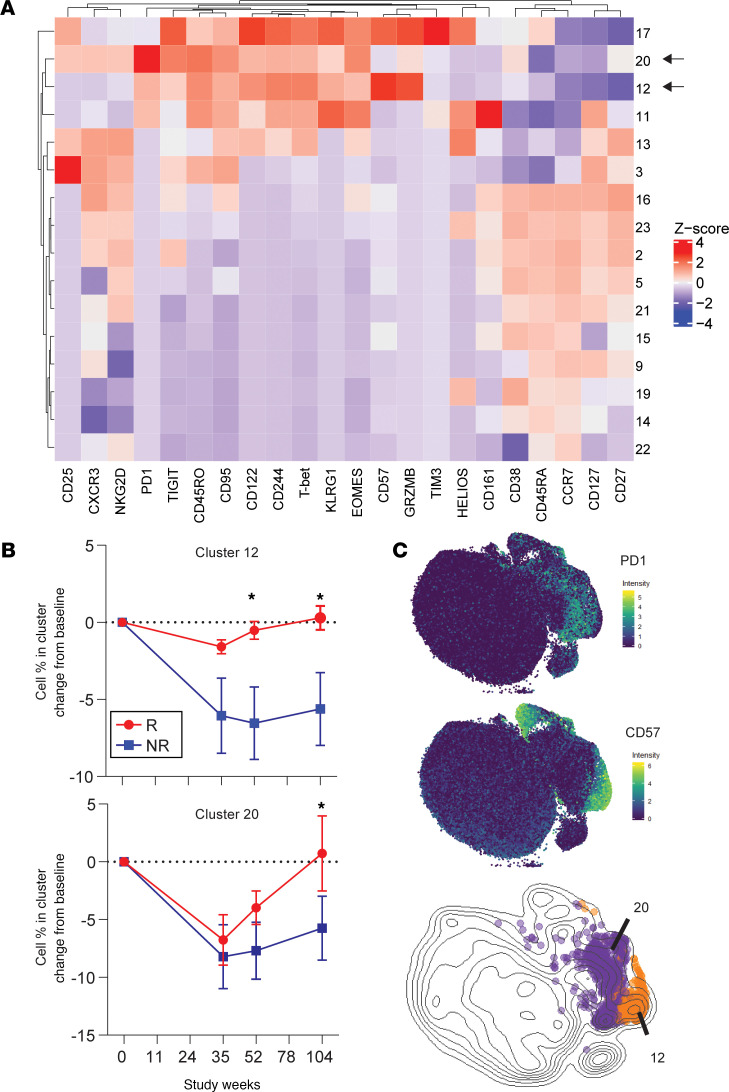
Two CD8+ memory T cell subsets identified by CyTOF analysis were associated with beneficial response to alefacept.(A) Heatmap shows median expression for each cluster that contained at least 1% of total cells. Color indicates column Z-score calculated from cluster median expression. Arrows denote the 2 IR-high clusters that correlated with response, clusters 12 and 20. Analysis included 12 subjects (6 responders [R]; 6 nonresponders [NR]). (B) Change from baseline percent of cells in clusters 12 and 20 plotted over time in 6 R and 6 NR. Differences between groups were analyzed by repeated-measures 1-way ANOVA with baseline adjustment and FDR multiple comparison correction. *P < 0.05. (C) t-SNE was used to visualize CyTOF data at a single-cell level. Expression intensity (asinh of MI) is colored on t-SNE plots for PD-1 and CD57 (top). Overlay of cluster 12 and 20 cells shown on density plot, color-coded as orange and purple, respectively (bottom).